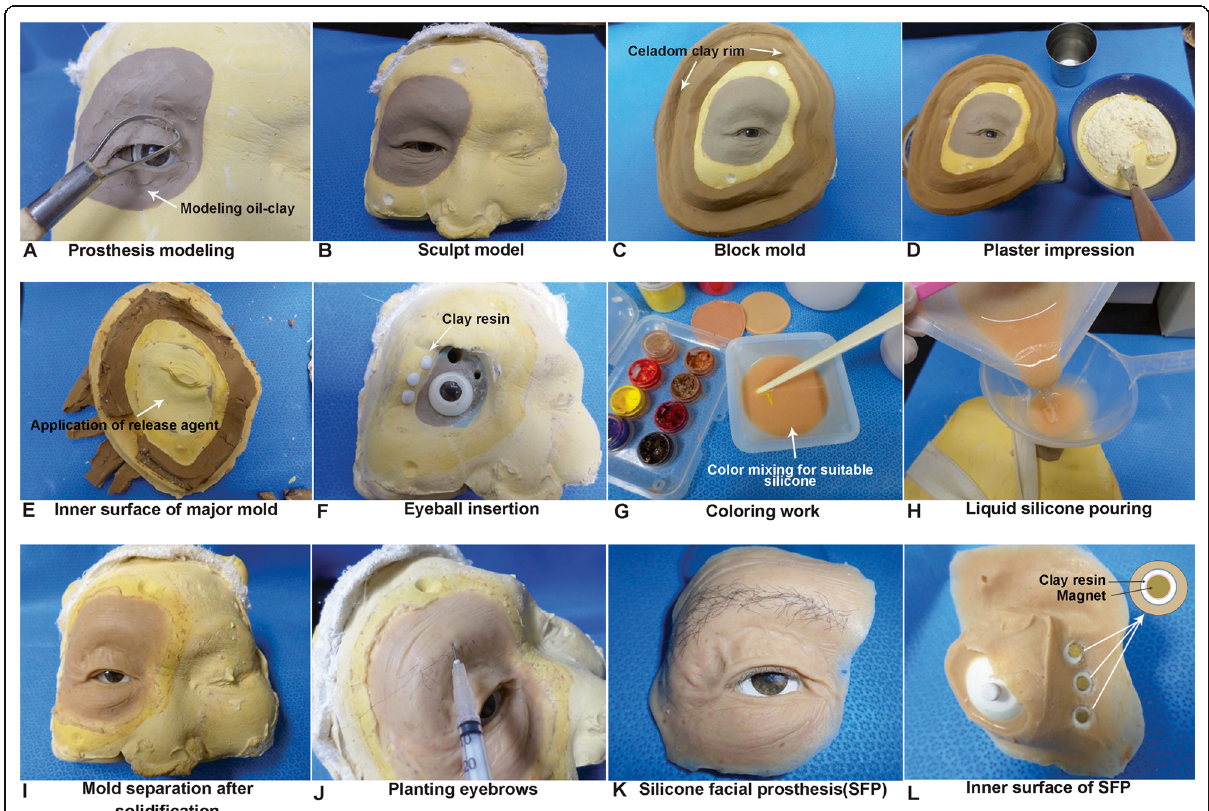
Fig. 3 Laboratory fabrication procedures for the orbital prosthesis showing a molding process ( a , b ) using a modeling oil-clay (NSP-soft®; Chavant, Inc., New Jersey, USA) on the major facial cast; preparation of a block mold using celadon clay ( c ) to create a mirrored outer appearance of the orbital skin area; pouring the plaster to make the major mold after Vaseline application to the gypsum area excluding the modeling clay ( d ); inner surface of the major mold after solidification ( e ); eyeball attachment after fabrication; the magnet plastic clay (Eyaco®, Goyang, Gyeonggi-do, Korea) mold adaptation on the magnet section in the master cast model ( f ); adding the liquid silicone color component (Ecoflex TM 00-10®; Smooth-On, Inc., Pennsylvania, USA) to the main silicone elastomers (Smooth-Cast®; Smooth-On, Inc., Pennsylvania, USA) to finalize the shade of the silicone base ( g ); pouring the liquid silicone into the main master cast through a small hole in the major mold ( h ); the initial and raw appearance of the silicone orbital prosthesis on the major facial cast ( i ) after solidification of the silicone (at least 6 h); trimming and implanting artificial hair in the eyebrow and eyelash areas ( j ); the outer appearance of the silicone orbital prosthesis ( k ); and the inner surface that contains the posterior part of the eyeball and the individual magnet with firm cementation ( l